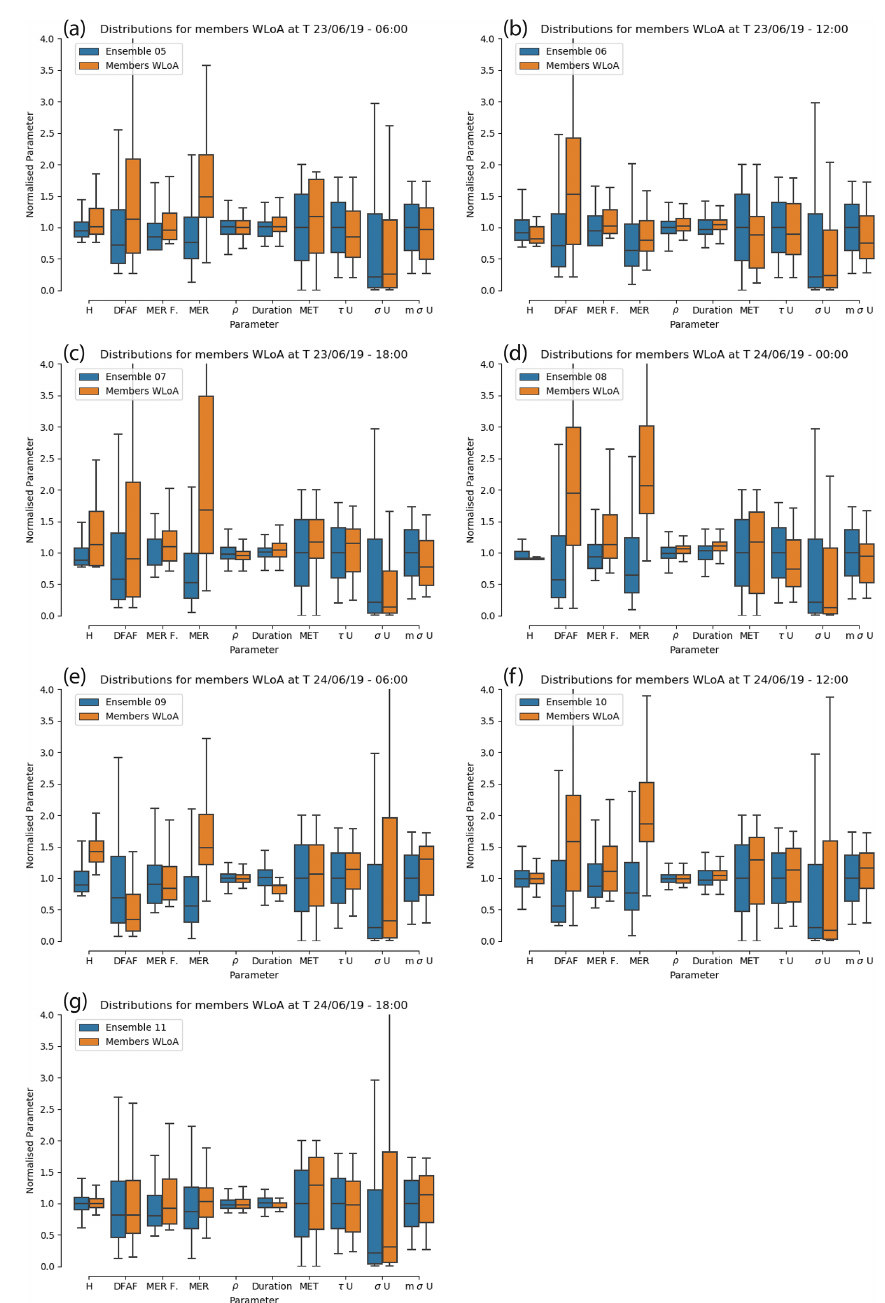
Figure A1. Evolution of parameters distributions for members within limits of acceptability (WLoA) for (a) Ensemble 05, (b) Ensemble 06, (c) Ensemble 07, (d) Ensemble 08, (e) Ensemble 09, (f) Ensemble 10, and (g) Ensemble 11. ρ , τU , σU , and mσU represent density, horizontal Lagrangian timescale for free tropospheric turbulence, standard deviation of horizontal velocity for free tropospheric turbulence, and standard deviation ( σ ) of horizontal velocity for unresolved mesoscale motions. In all panels, the mass eruption rate (MER) is plotted to show its variation, although it is not explicitly perturbed in any of the ensembles. Each parameter in the box plots is normalised by dividing each individual value from the ensemble members by the mean of that entire parameter range from the selected